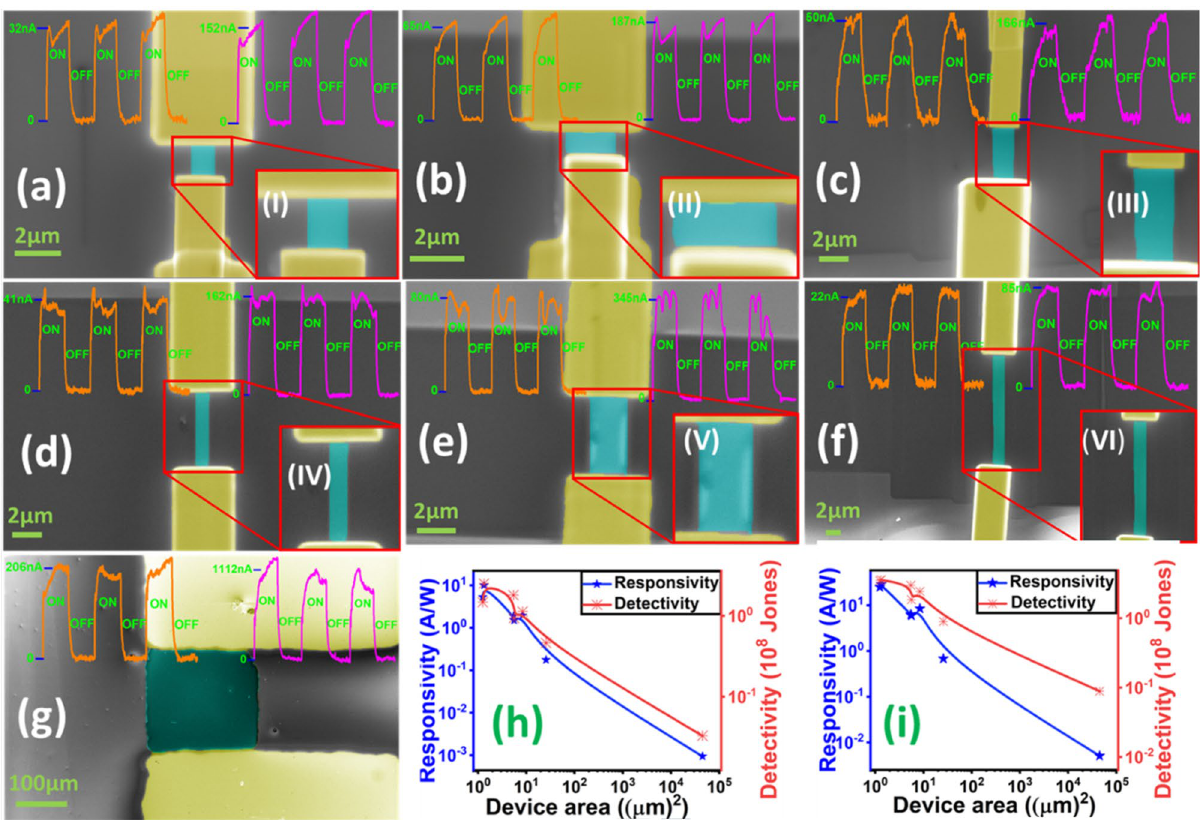
Figure 4. Active area dependent photocurrent measurements. ( a – g ) False coloured FESEM images of different active areas and insets (I- VI) show the zoom section of constricted WTe 2 channel respectively. Curves (orange and magenta) on top of FESEM images represent time dependent photocurrent measurements performed at bias voltages 0.5 V and 2 V respectively. ( h , i ) Show the responsivity (blue) and detectivity (red) curves at bias volt 0.5 V and 2 V